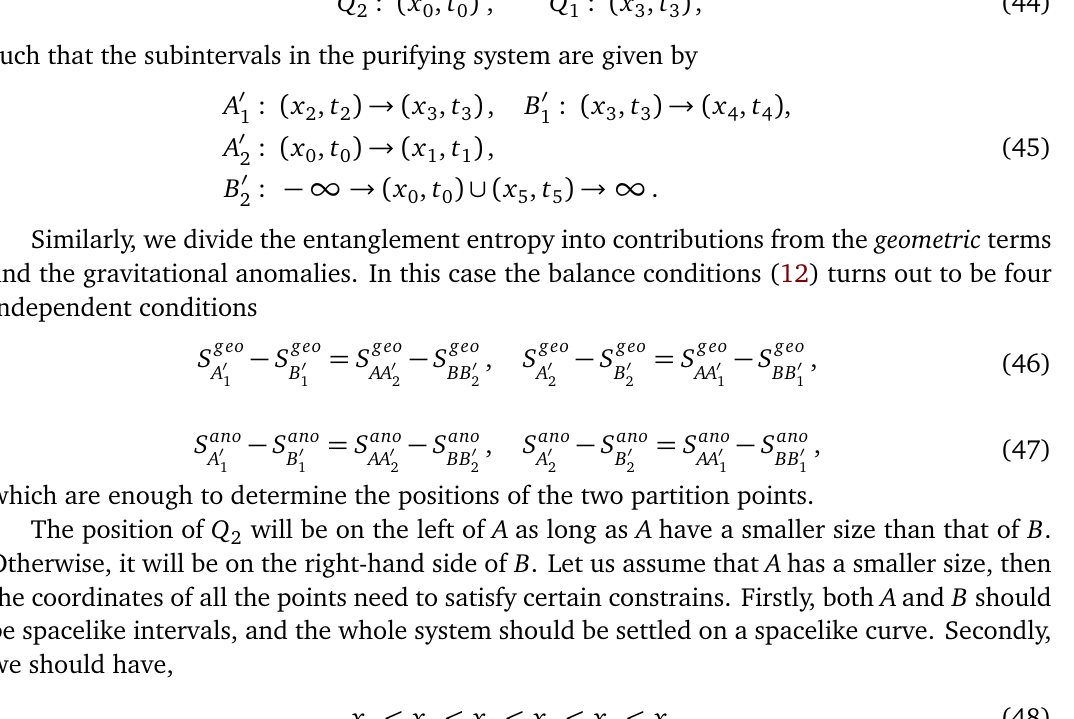
Figure 3: Figure extracted from [ 2 ] , licenced under CC-BY 4.0. Setup for two non- adjacent covariant intervals A and B in the vacuum state of a CFT anomalies. The auxiliary system A (cid:48) B (cid:48) is partitioned by the points Q subintervals A (cid:48) , A (cid:48) , B (cid:48) , B (cid:48) 1 2 1 2